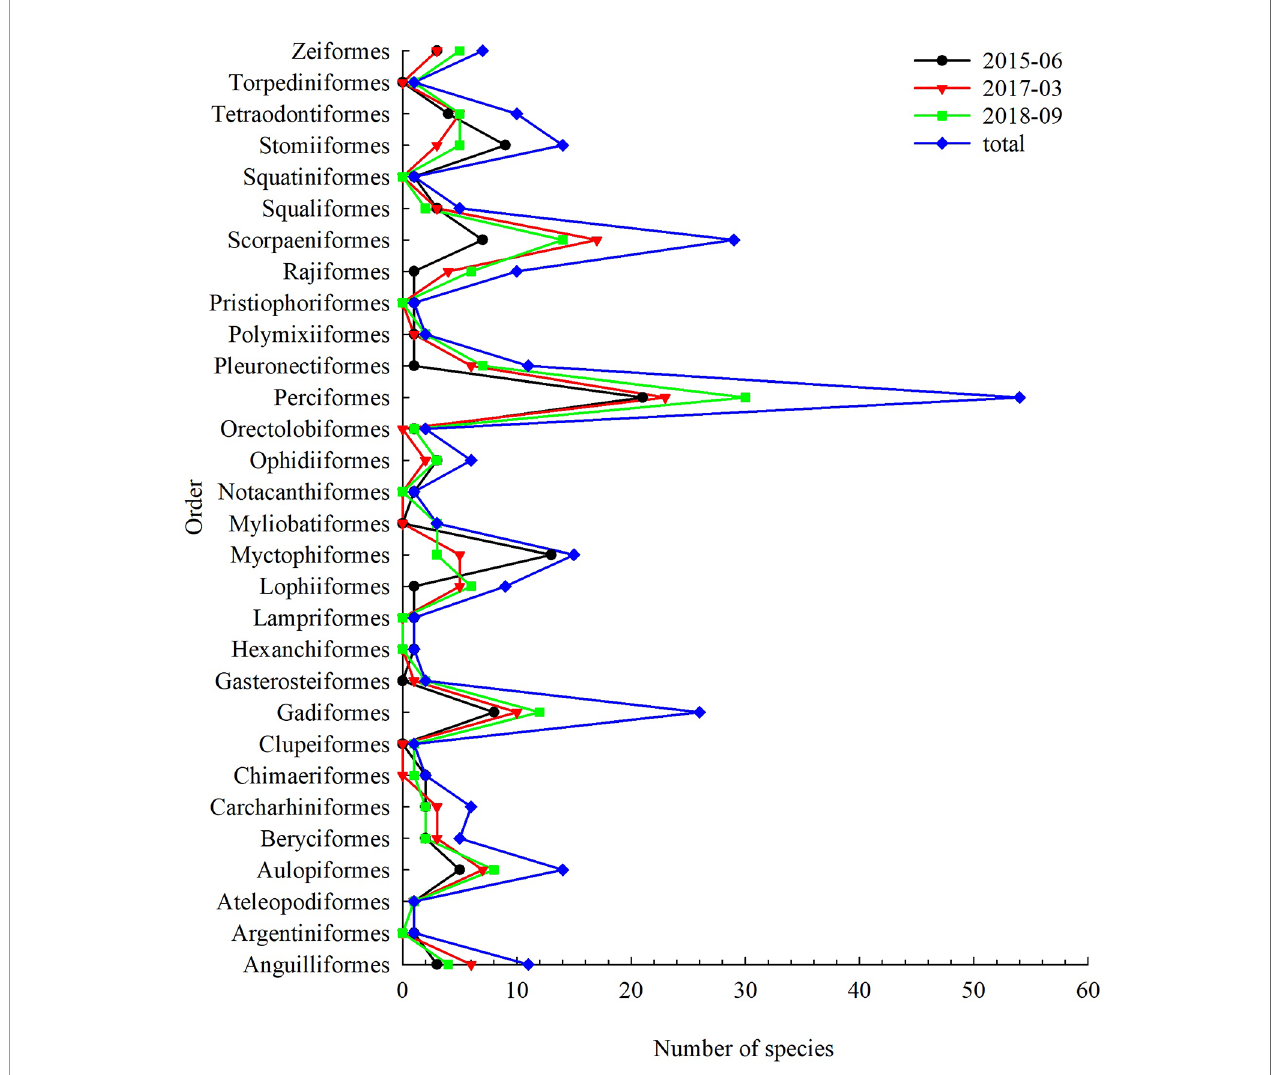
FIGURE 2 | Species number demersal fi sh by order over the